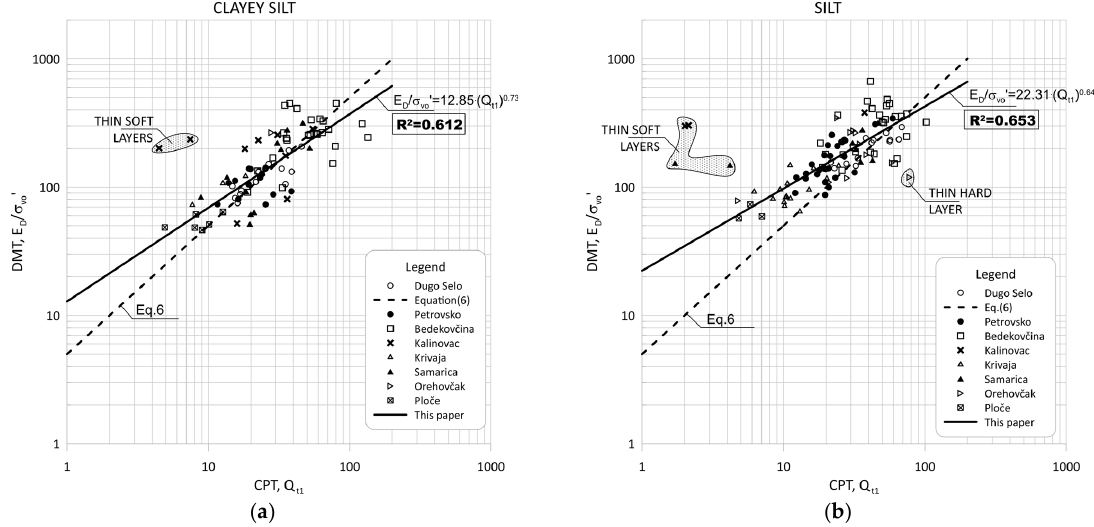
Figure 9. Summary of measured values from adjacent CPT and DMT profiles of Q t 1 versus E D / σ (cid:48) v 0 for: ( a ) clayey silt (0.6 < I D < 0.8, 2.05 < I c < 2.95); ( b ) silt (0.8 < I D < 1.2, 2.05 < I c <